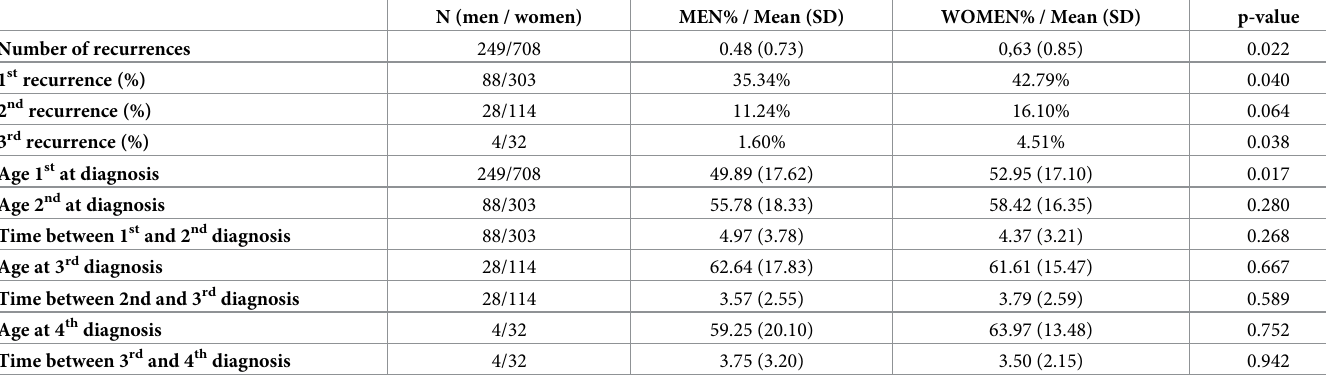
Statistic used: Mann–Whitney U (Chi square and Fisher test were used for the percentage of subjects suffering a first, second or third